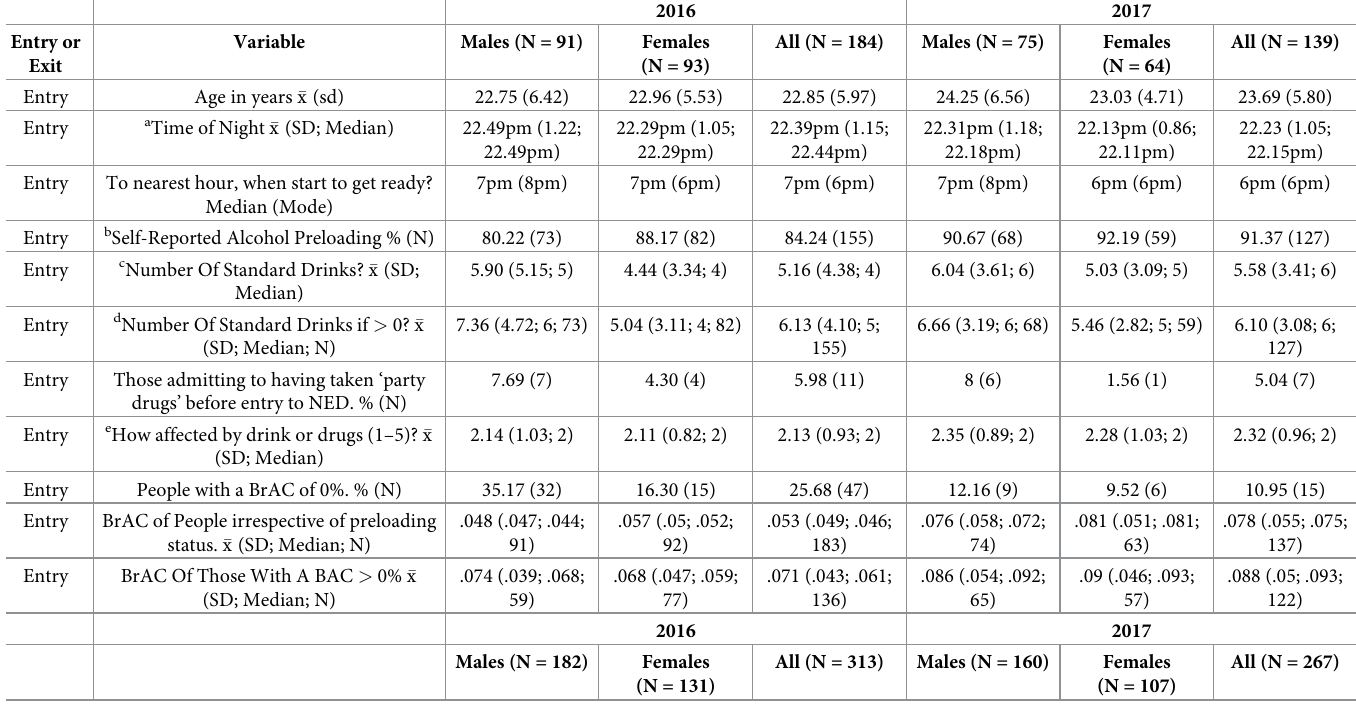
Table 2. Big night out entry & exit